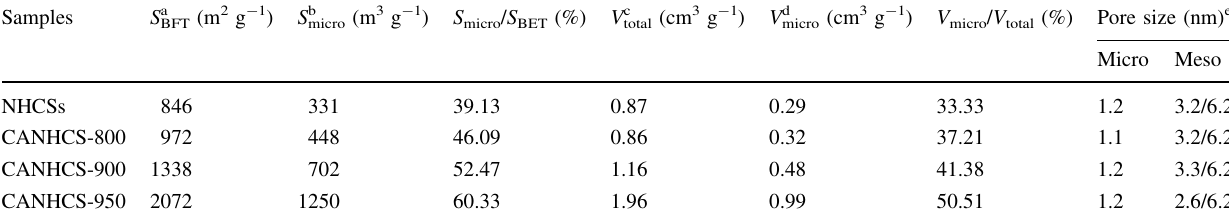
Table 1 Texture parameters of NHCSs and CANHCSs activated at different temperatures